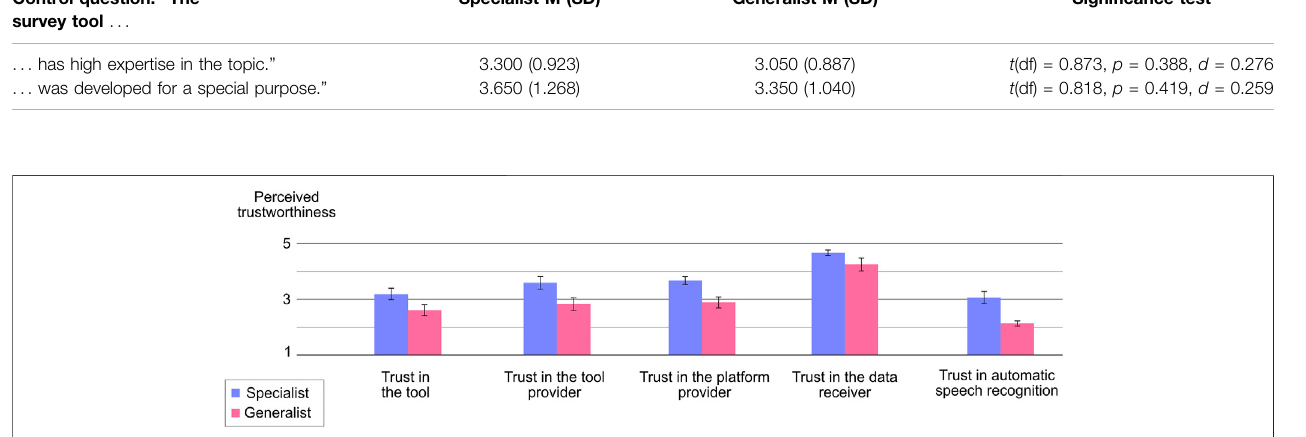
TABLE 3 | Results of manipulation check. Control question: “ The survey tool